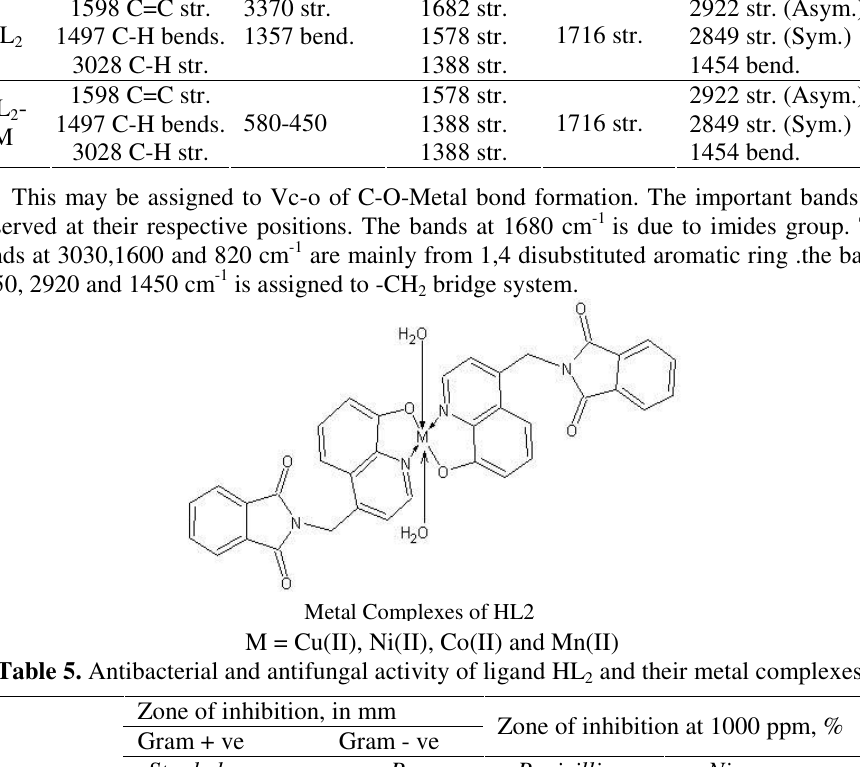
Table 4. Infrared frequencies of HL